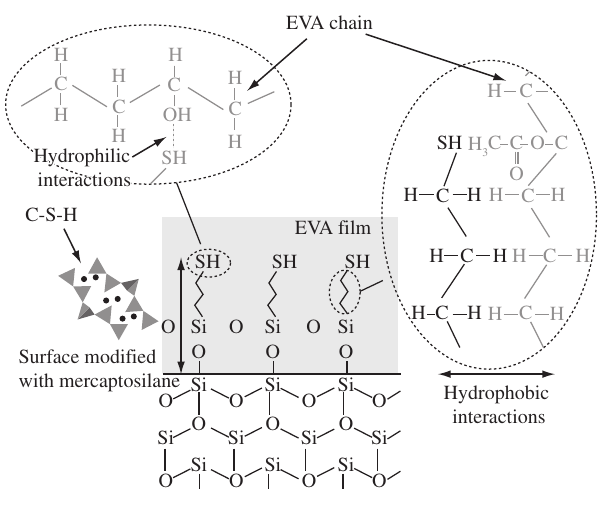
Figure 12. Schematic representation of physico-chemical interactions between mercaptosilanes and EVA